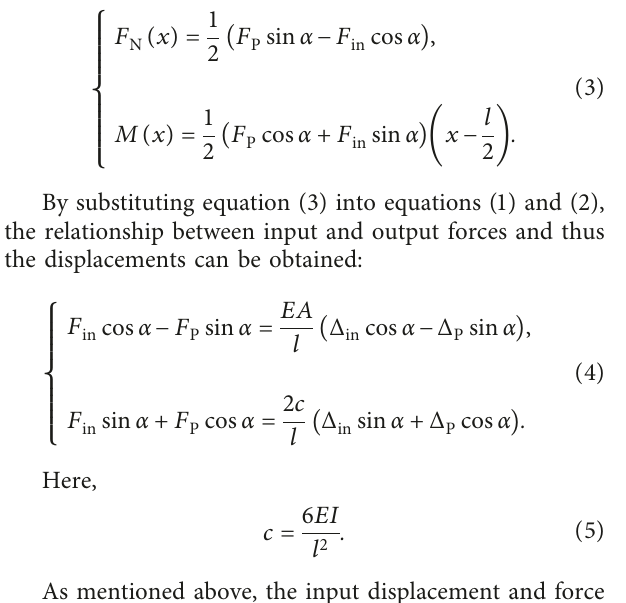
Figure 5: Model of a quarter of the rhombic